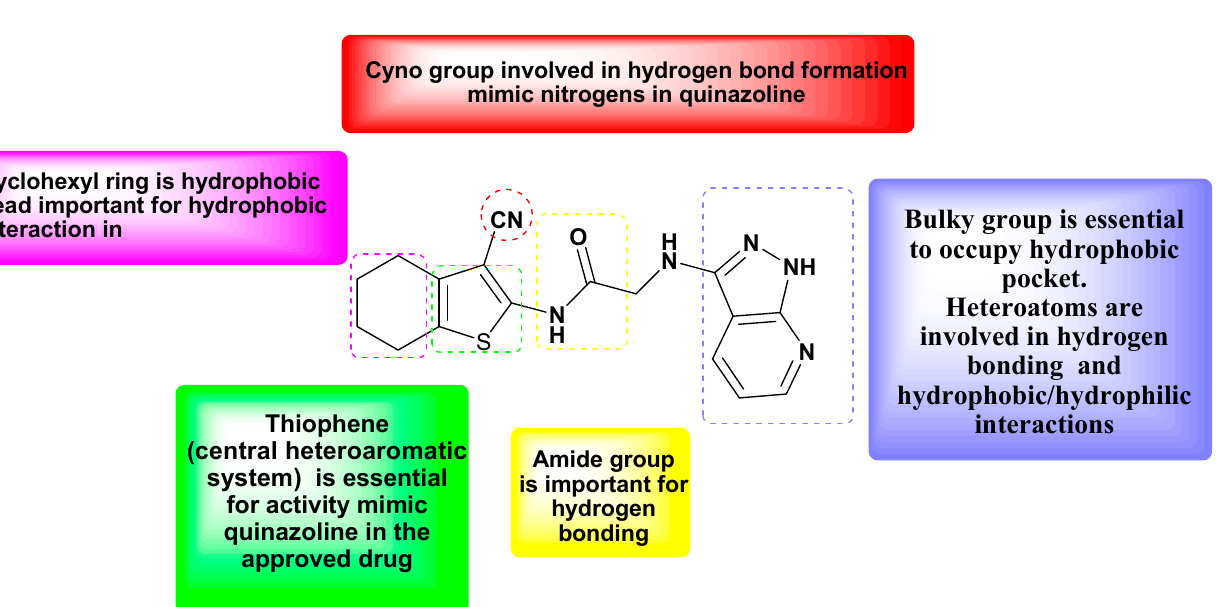
Figure 10. The observed structure–activity relationships of the designed molecules as promising dual EGFR/HER2 inhibitors.